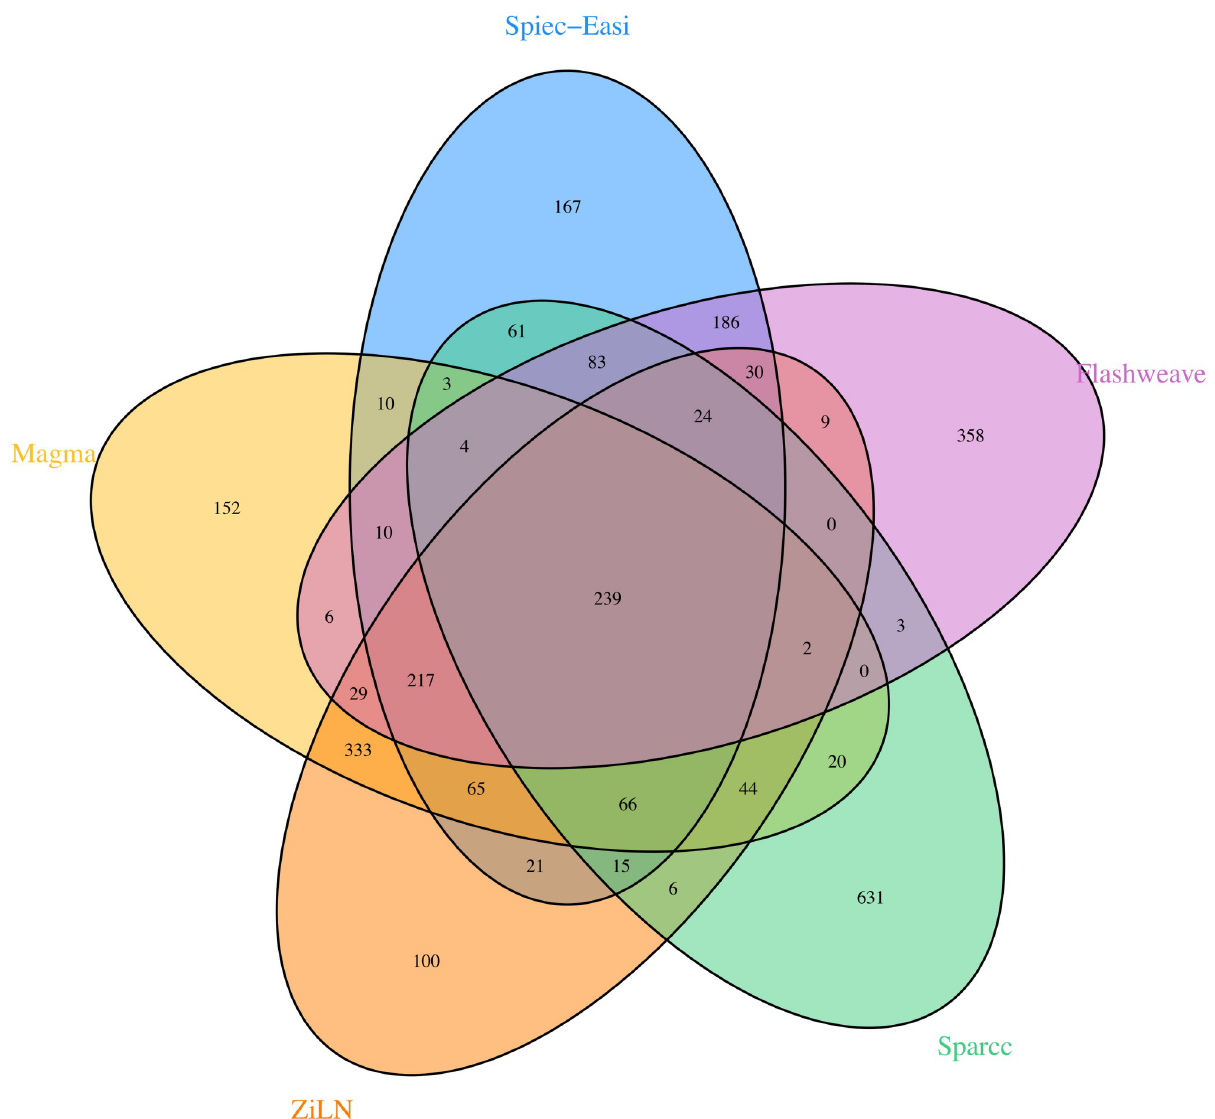
Fig 5. Venn diagrams displaying the overlap between the species associations sets predicted by the different methods on the human gut taxonomic profiles of the LifeLines-Deep cohort [33]. To simplify the plot, a threshold was applied here to remove taxa absent in more than 20% of the samples, leading to a total of 565 species. It can be seen that our method has the highest ratio (239/100) of edges predicted by all methods versus idiosyncratic ones, but that overall substantial differences remain among the predictions of the various